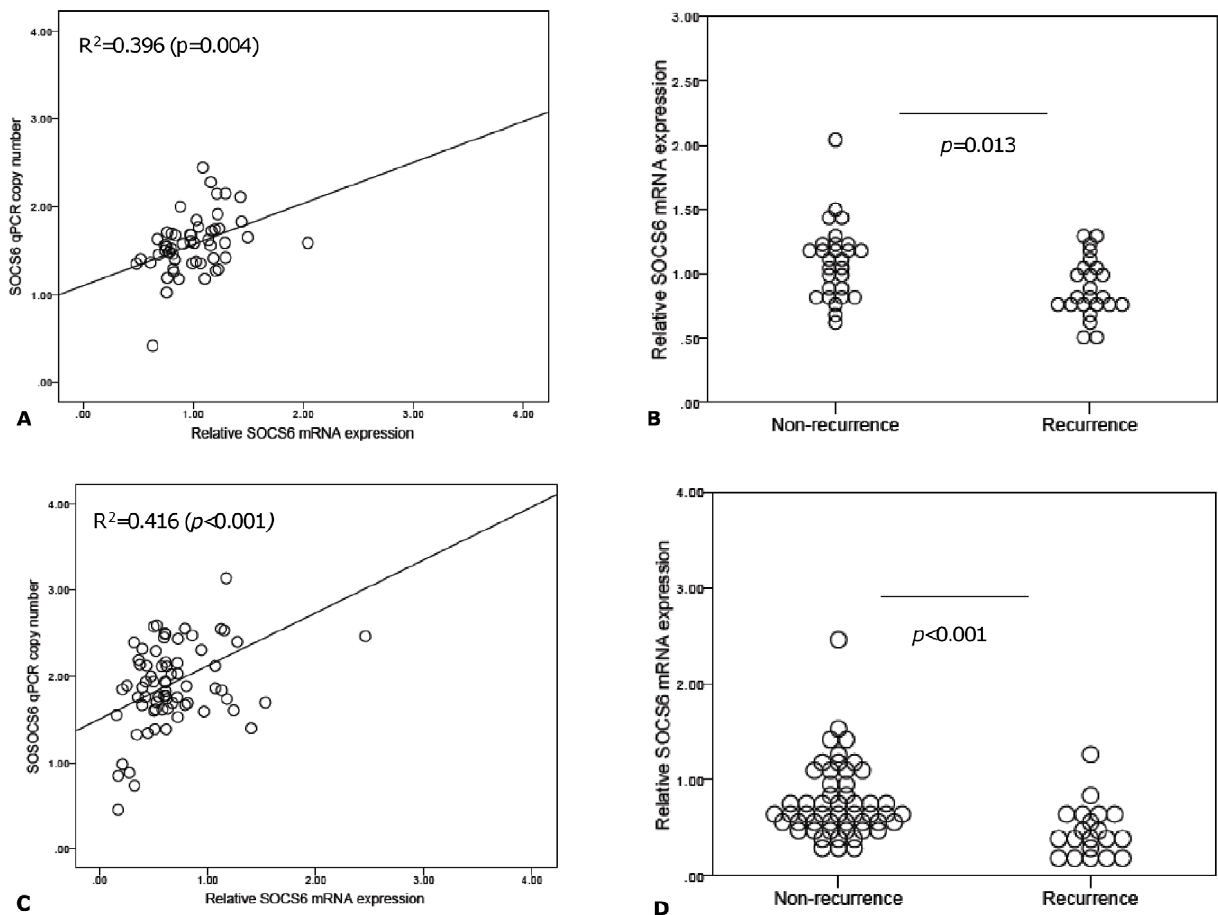
Figure 5. Relationship between SOCS6 mRNA expression, copy number and recurrence phenotype. Figure 5A and 5C are scatter plots of qRT-PCR derived SOCS6 mRNA expression (x-axis) and qPCR-derived SOCS6 copy number (y-axis) in training set (n=62) (a) and test set (n=72) (c) respectively. Figure 5B and 5D represent SOCS6 mRNA levels (y-axis) ad recurrence phenotype (x-axis) in the training and test sets respectively. Pearson’s correlation coefficient was used to determine any association between SOCS6 qPCR derived copy number and mRNA levels. Mann-Whitney U test to was used to assess for any differences in copy number between recurrence phenotypes and p values , 0.05 were deemed significant.